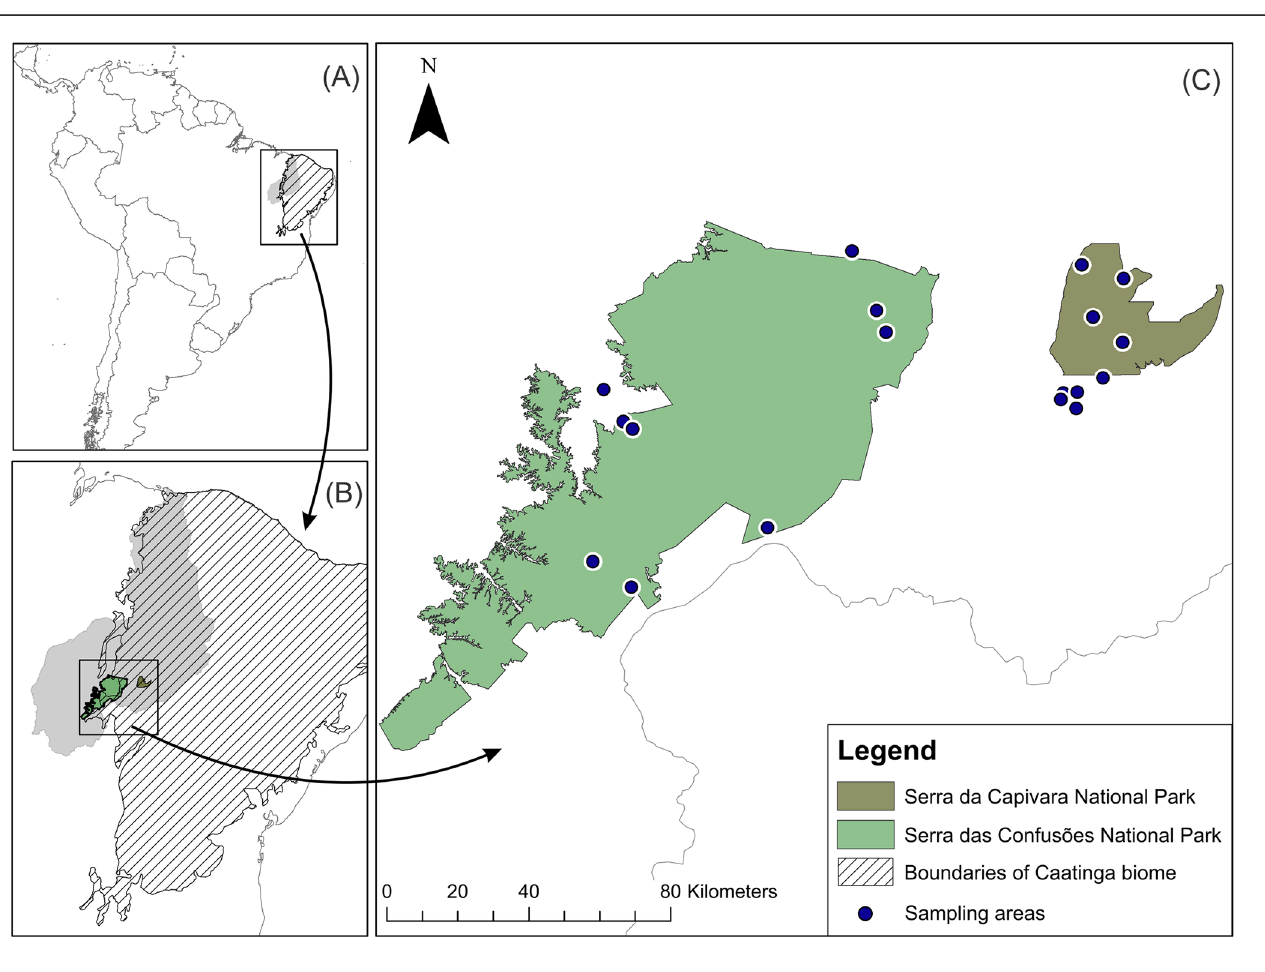
Fig 1. Map of the study area showing the location of sampling areas in the Serra da Capivaraand Serra das Confus õ esNational Parks. Blue circles indicatelocationsof the 18 samplingareas. A) Wide view of the location of study area in relationto South America, B) locationof the study area within the state of Piauı´and in the Caatingabiome, C) location of the samplingsites in the NationalParks and vicinities. Shapefileof biome are providedby MMA (Ministe´rio do Meio Ambiente do